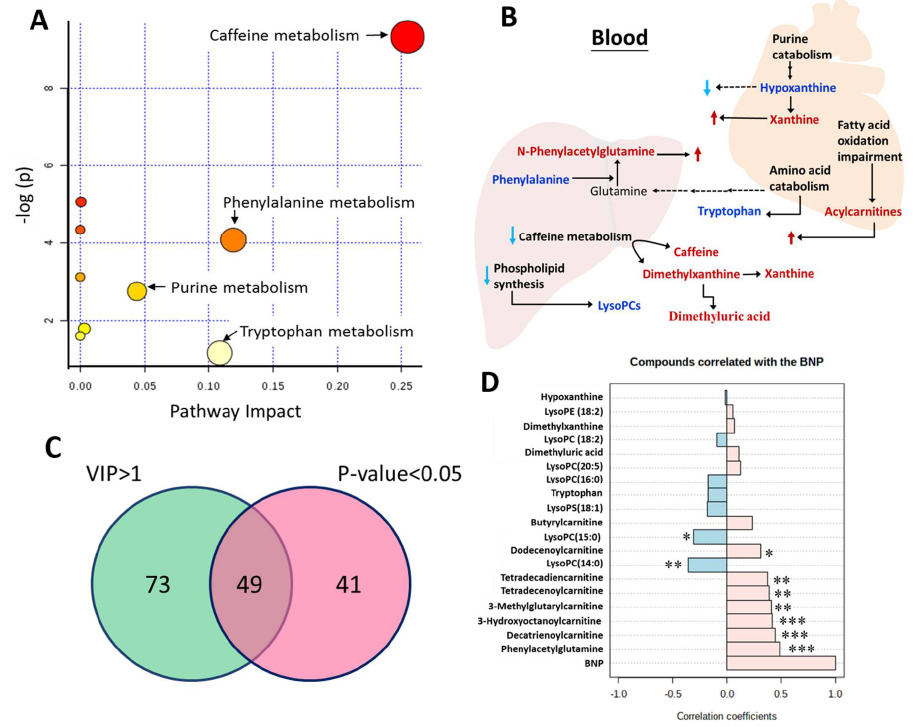
Figure 2. Identification of metabolites between event and non-event groups. ( A ) Pathway analysis reveals that several pathways were changed in HF patients with event group. Metabolic disturbances are mapped to pathways involved in amino acid metabolism, ca ff eine metabolism, and purine metabolism. ( B ) Scheme of metabolic disturbance associated with poor heart failure-related outcomes. Red metabolites: those significantly increasing in event group; blue metabolite: those significantly decreasing in event group; dark metabolites: not measured or no significant di ff erence between event and non-event groups. ( C ) Venn diagram shows the number of metabolites with VIP greater than 1 and significantly ( p < 0.05) altered between event and non-event groups. ( D ) Significantly di ff erent metabolites were correlated with level of BNP by Pearson’s correlation coe ffi cient analysis. * p < 0.05, ** p < 0.01, *** p <